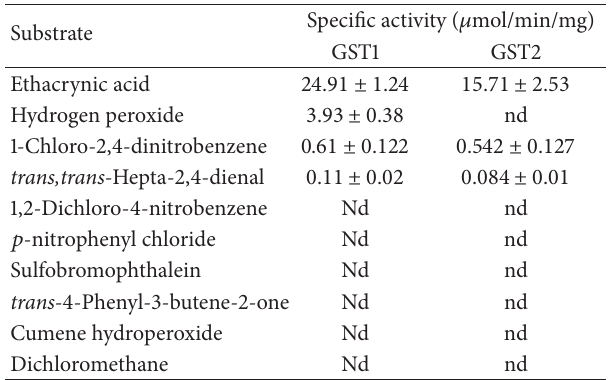
Table 1: Specific activities of GST1 and GST2 towards selected